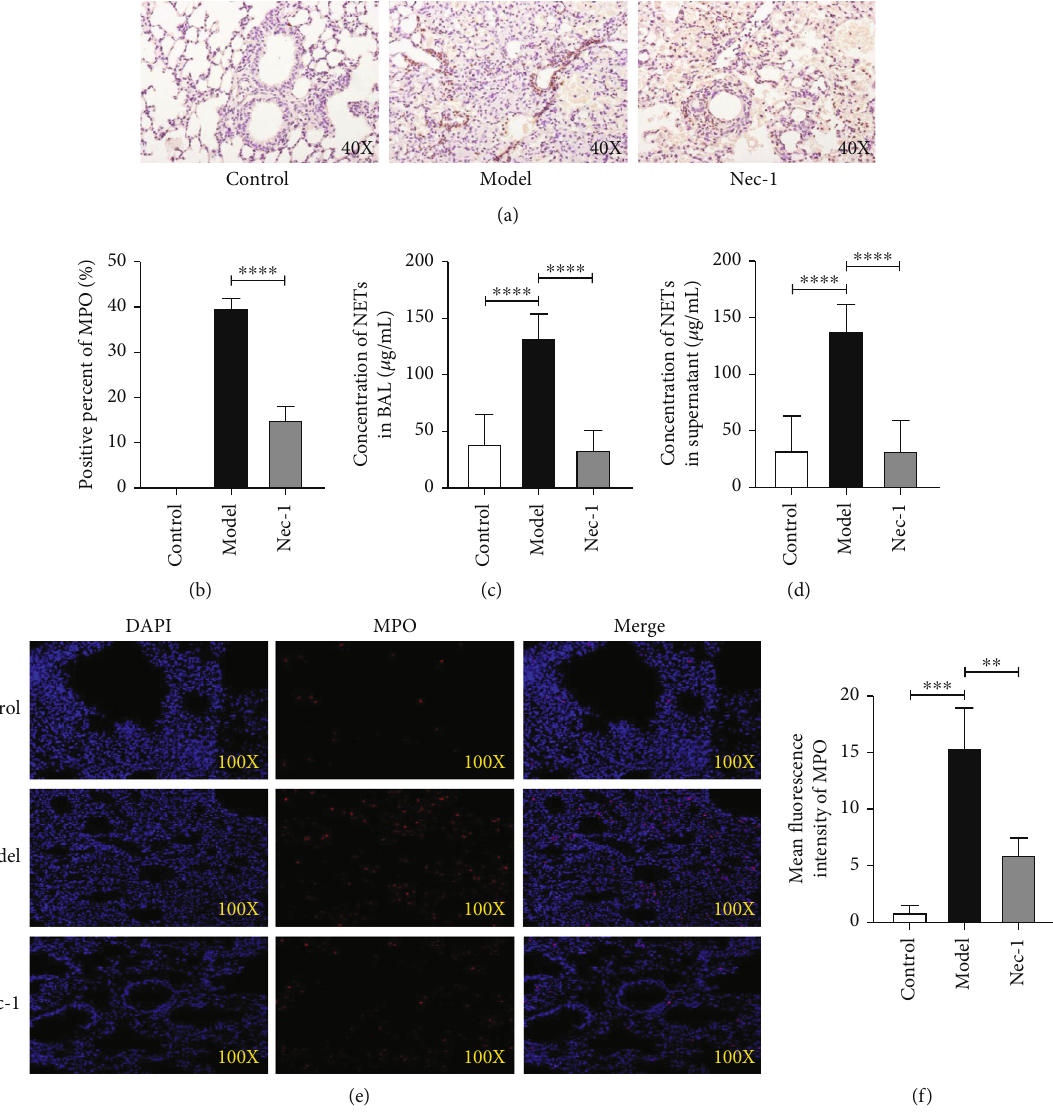
Figure 4: Nec-1 prevented the release of neutrophil extracellular traps (NETs) in mice with di ff use alveolar haemorrhage. (a) Representative images of the immunohistochemistry of MPO from di ff erent groups. (b) The positive rate of MPO expression in di ff erent groups was calculated using ImageJ. (c) The mean fl uorescence intensity of SYTOX Green-stained extracellular DNA in the bronchoalveolar lavage (BAL) of mice was measured using a microplate reader. (d) The mean fl uorescence intensity of SYTOX Green-stained extracellular DNA in the peripheral blood supernatant was measured using a microplate reader. (e) Representative immuno fl uorescence images of the nucleus and myeloperoxidase (MPO) in lung tissues from di ff erent groups. Nuclei were stained with 4 ′ ,6-diamidino-2-phenylindole (DAPI) (blue). MPO was stained with a fl uorescent secondary antibody (red). The merge channel was mixed with two di ff erent colours. (f) The average fl uorescence intensity of MPO in di ff erent groups was calculated using ImageJ. Data are presented as mean ± standard deviation. Values were expressed as mean ± standard error of the mean of three independent experiments ( ∗∗ P < 0 : 01 , ∗∗∗ P < 0 : 001 , and ∗∗∗∗ P < 0 : 0001